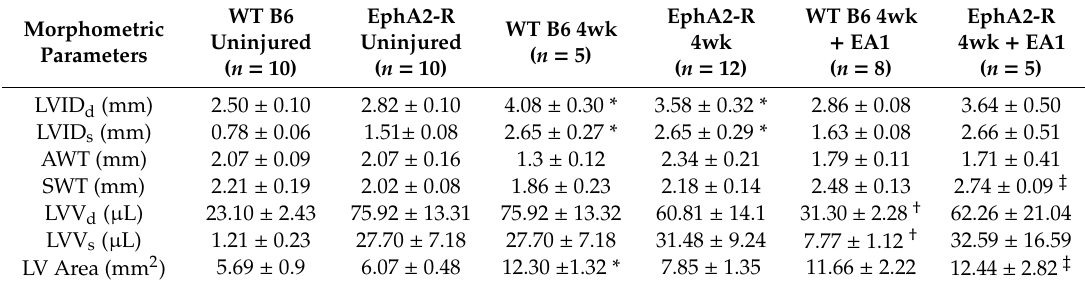
Table 1. Morphometric measures in WT and EphA2-R-M mouse